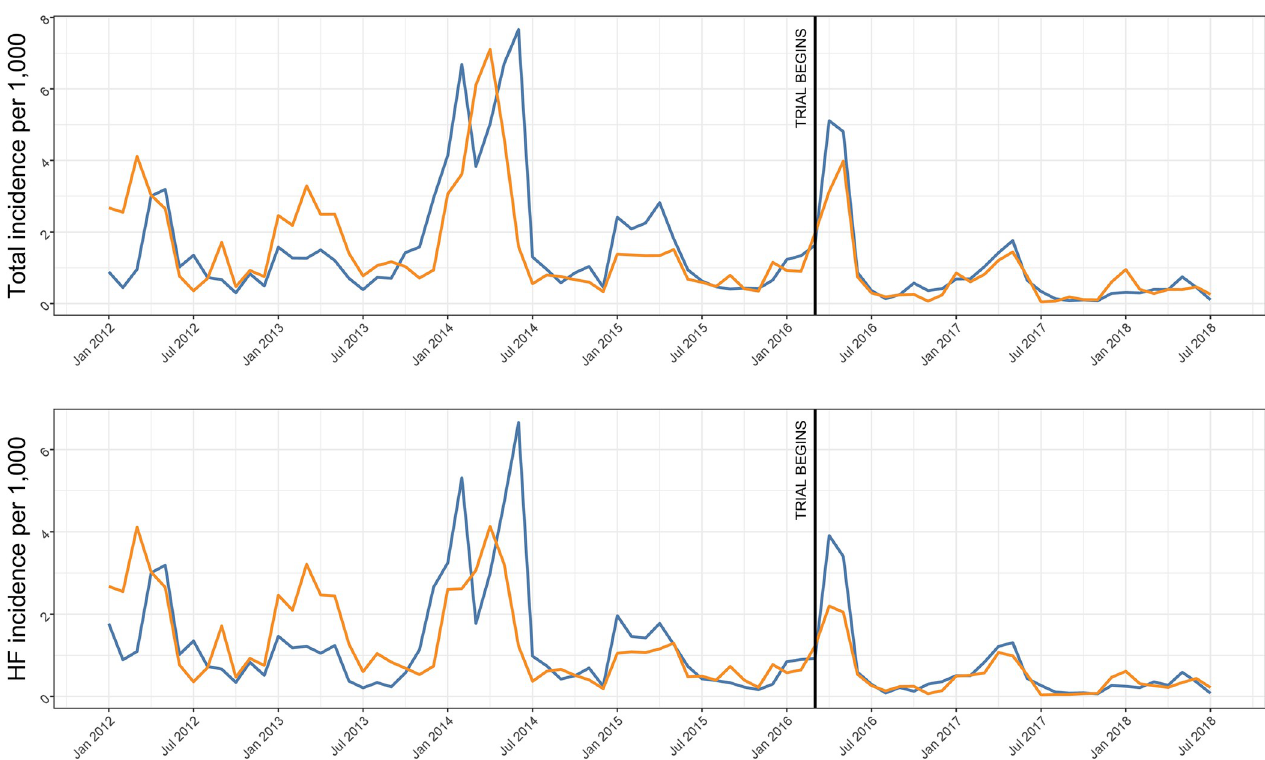
Fig 2. Median confirmed population malaria incidence for the entire HFCA (total) or just those identified at the health facility (HF). RFDA (blue) and RFTAT (orange) arms are